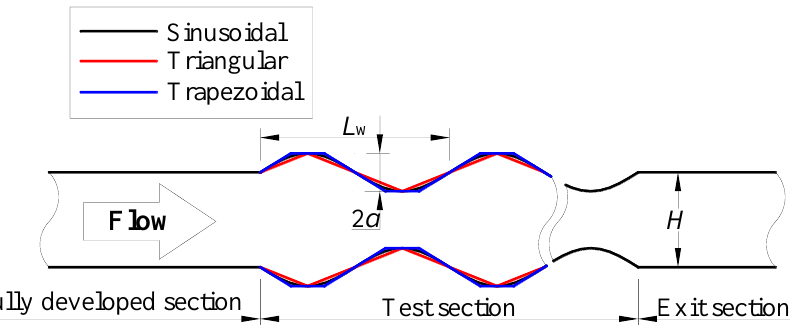
Figure 2. Geometries of the channel with wall corrugation. H is the channel height. The computational domain was divided in the fully developed section, the test section and the exit section, respectively. The lengths of these three sections were 8 H , 12 H and 4 H . L w is the wavelength, and a is the wave amplitude.